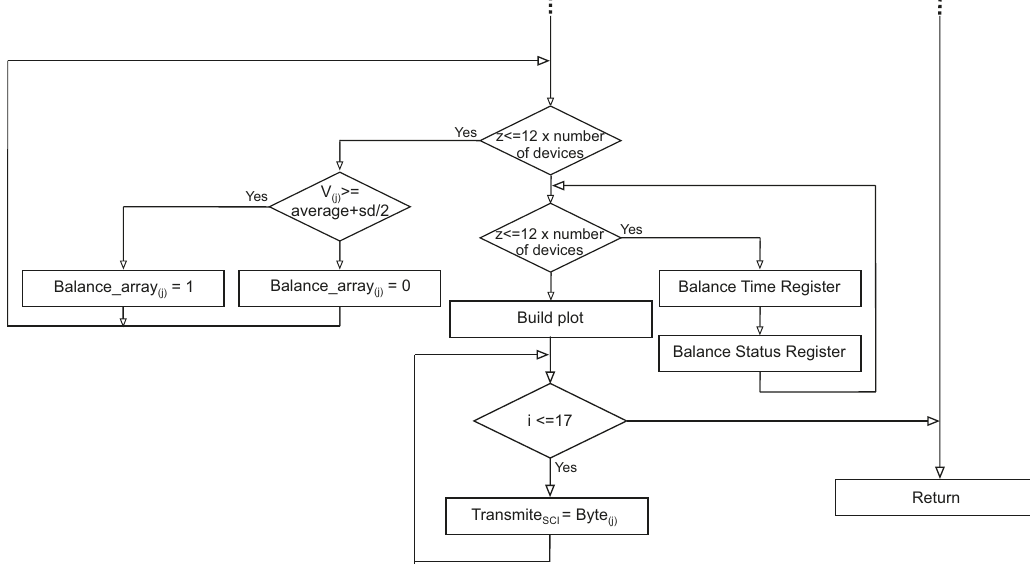
Figure 14. Flowchart of the program implemented in the main control unit—Fourth Segment.